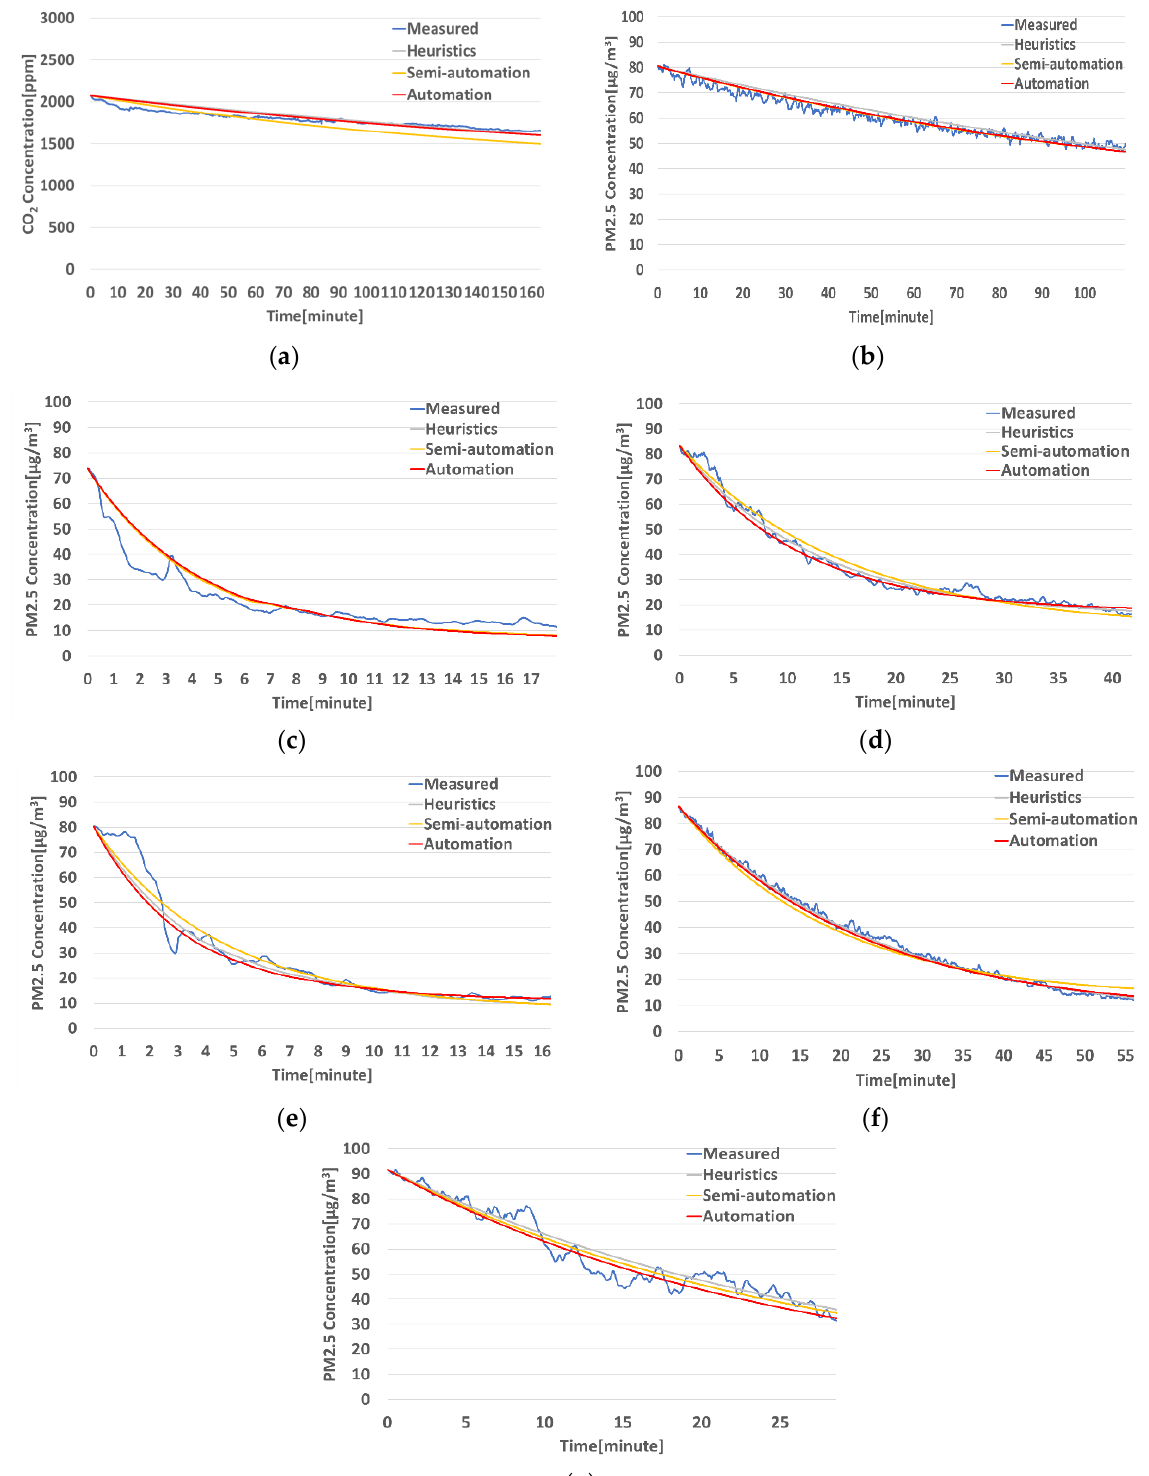
Figure 9. Measured reference and the first principle model responses by the automated, semi- automated, and heuristic calibrations for Case I. ( a ) CO 2 decay scenario. ( b ) PM2.5 decay scenario. ( c ) Door-open scenario. ( d ) Window-open scenario. ( e ) Cross-ventilation scenario. ( f ) Air purifier scenario. ( g ) ERV